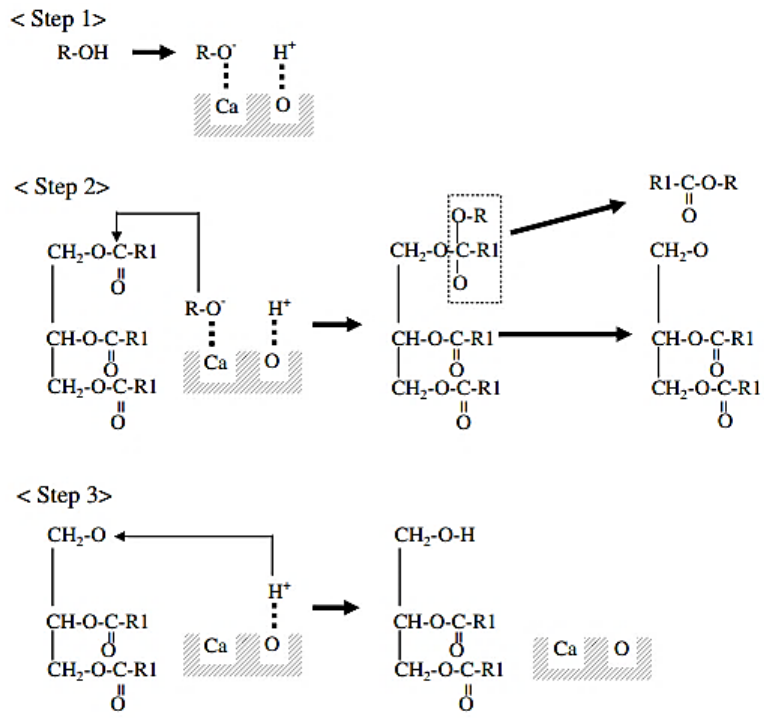
Figure 5. Reaction route of transesterification of triglyceride with methanol using CaO [2]. In this experiment, a molar ratio of 3:1 was used as a starting point, and this ratio was altered to 15:1, while the reaction time and temperature remained constant at 120 min and 60 ◦ C, respectively. The baseline condition of the reaction was derived from a prior study [4]. The catalyst concentration was maintained at 5% by weight throughout the reaction, which was agitated at 600